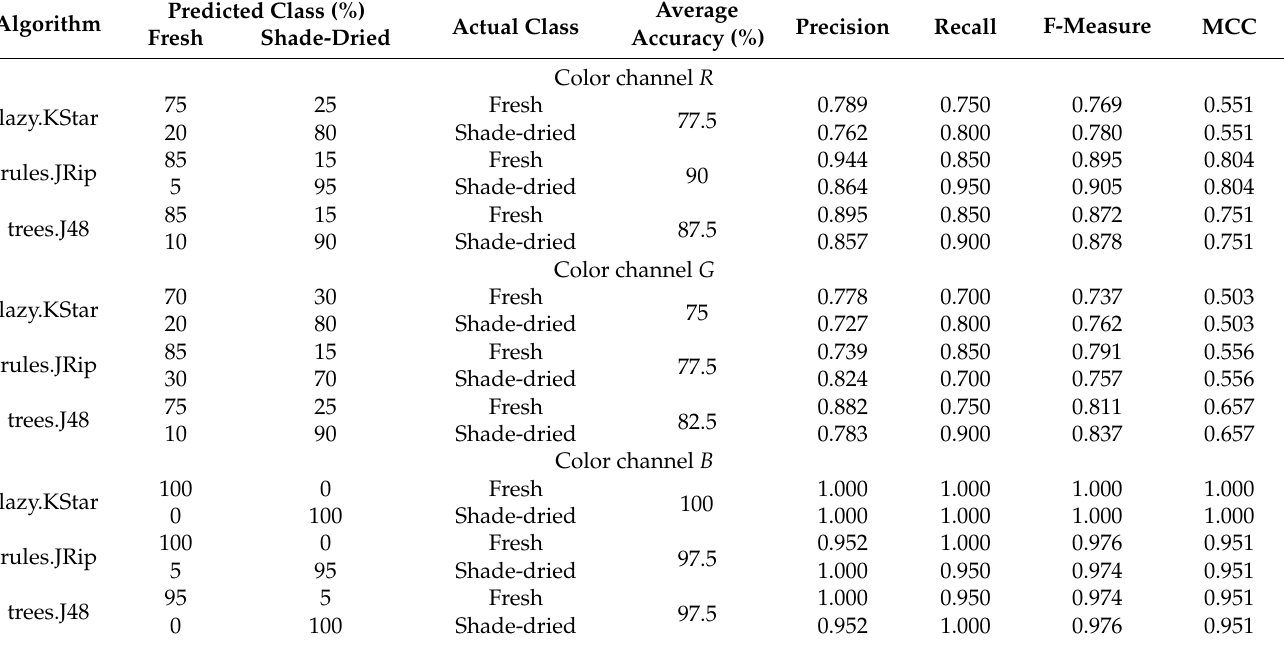
Table 7. The performance metrics of the classification of the dorsal side of fresh and shade-dried mint leaves based on selected textures of images in color channels R , G , and B from color space RGB.